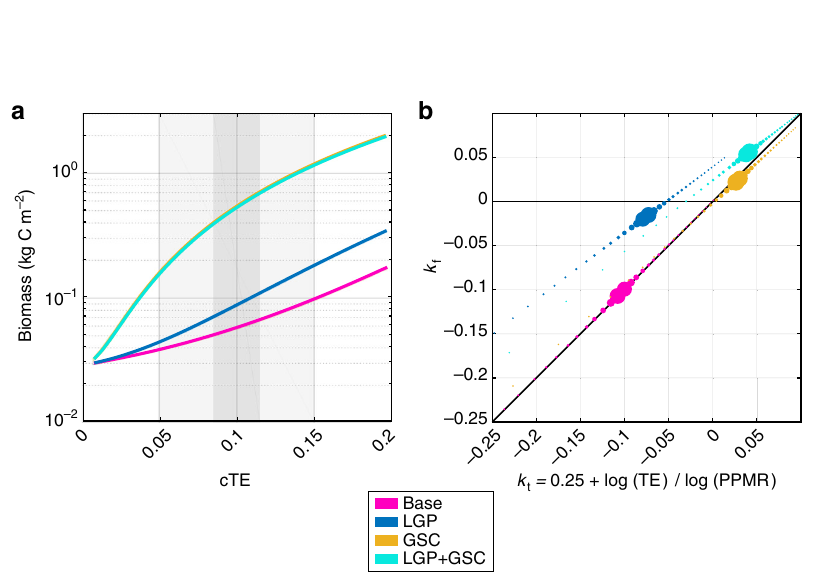
Fig. 3 Effects of GSCs and LGPs on biomass density and ecosystem structure. a Biomass density versus community trophic ef fi ciency (cTE) where gray shading shows distribution of cTE for marine ecosystems (cTE = 0.101 ± 0.058). b Mass scaling coef fi cient from least squares fi t, k f , versus calculated theoretical value, k t , from size-spectra theory. Size of data points represents the distribution of cTE for marine